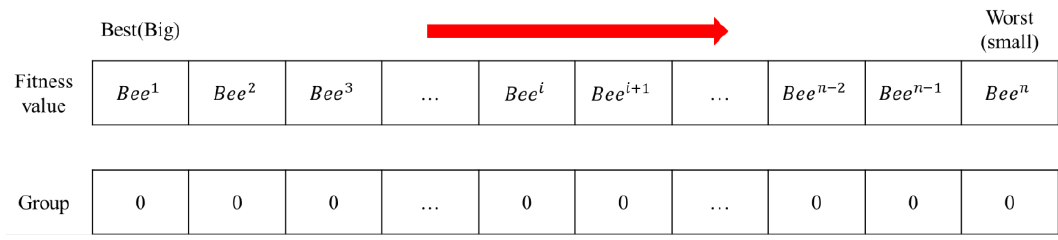
Figure 11. Schematic of ranked fitness values.